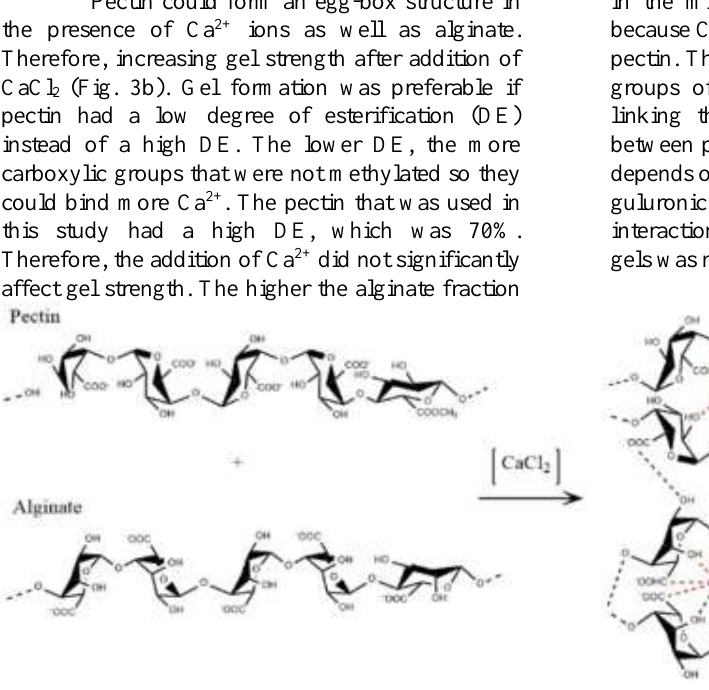
Figure 6. Interaction between alginate and pectin in CaCl 2 solution Carrageenan could undergo ionic